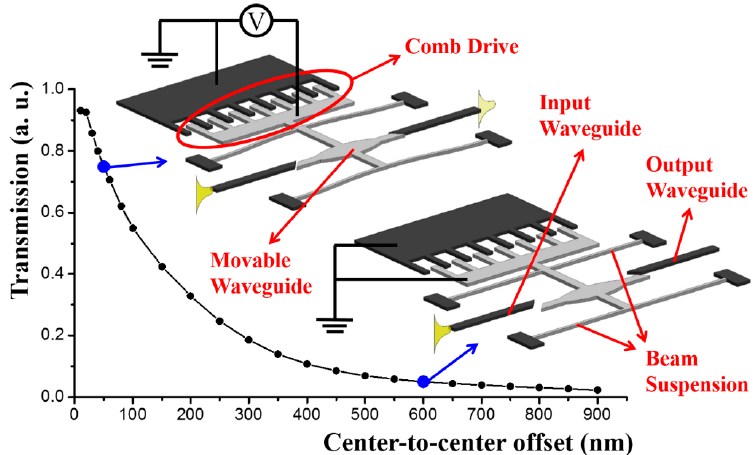
Figure 2. Finite difference time domain (FDTD) simulation results of the normalized transmission of the segmented waveguides configuration with respect to the center-to-center offset of the waveguide segments. The inserts denote the “on” and “off” states of the switch. The light grey parts denote movable structures while the dark grey parts indicate fixed structures. (The schematics in the figures below follow the same rule.)